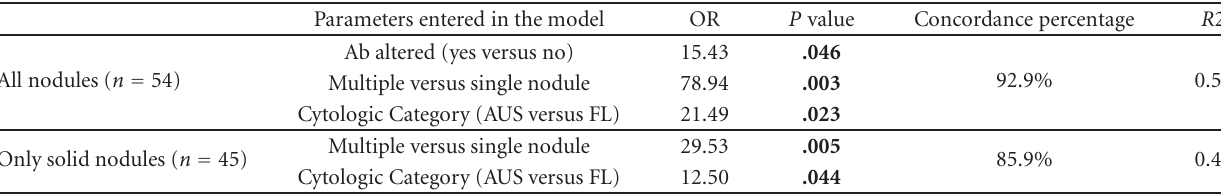
Table 3: Multivariate logistic analysis of the probability of identifying a carcinoma versus an adenoma by clinical, echographic features and cytologic category.